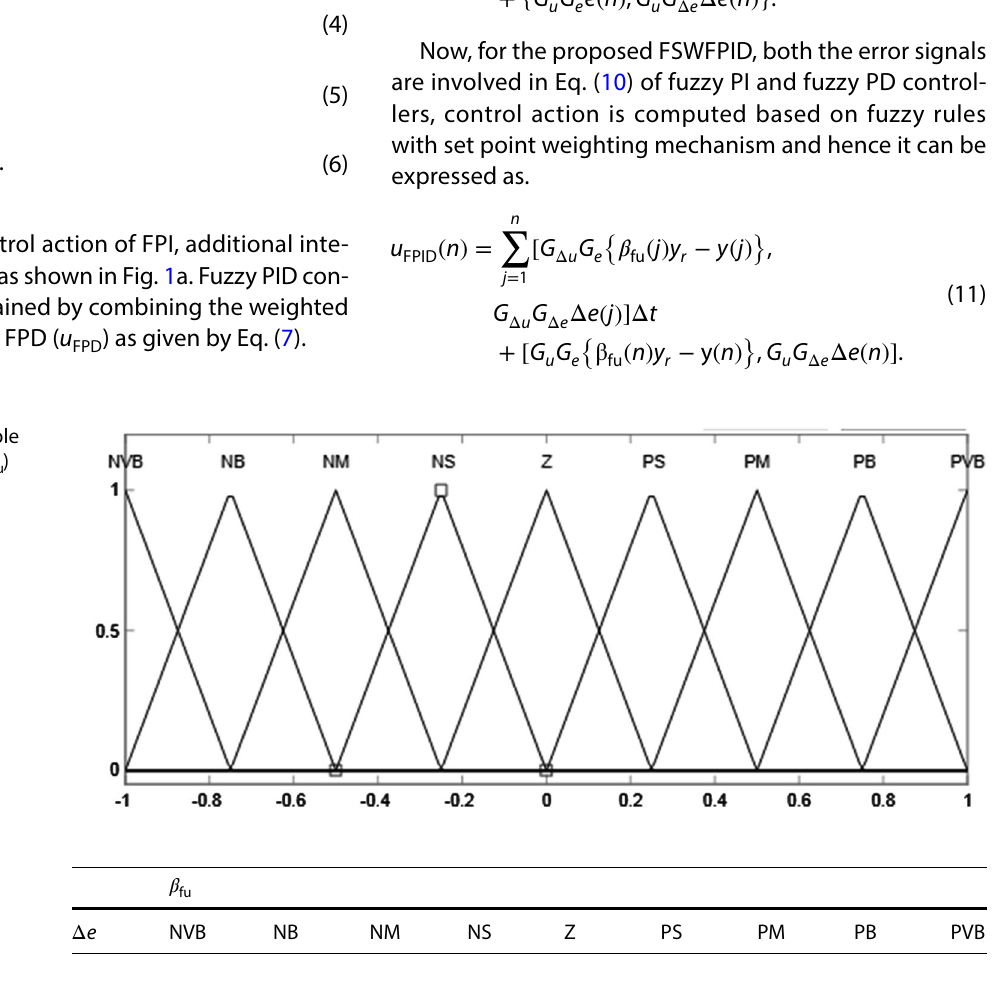
Table 1 Nine fuzzy